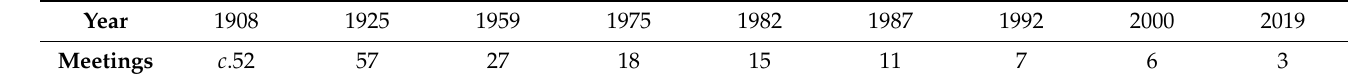
Table 5. Glanton/Reunited (Kelly–Lowe–Glanton) meetings,